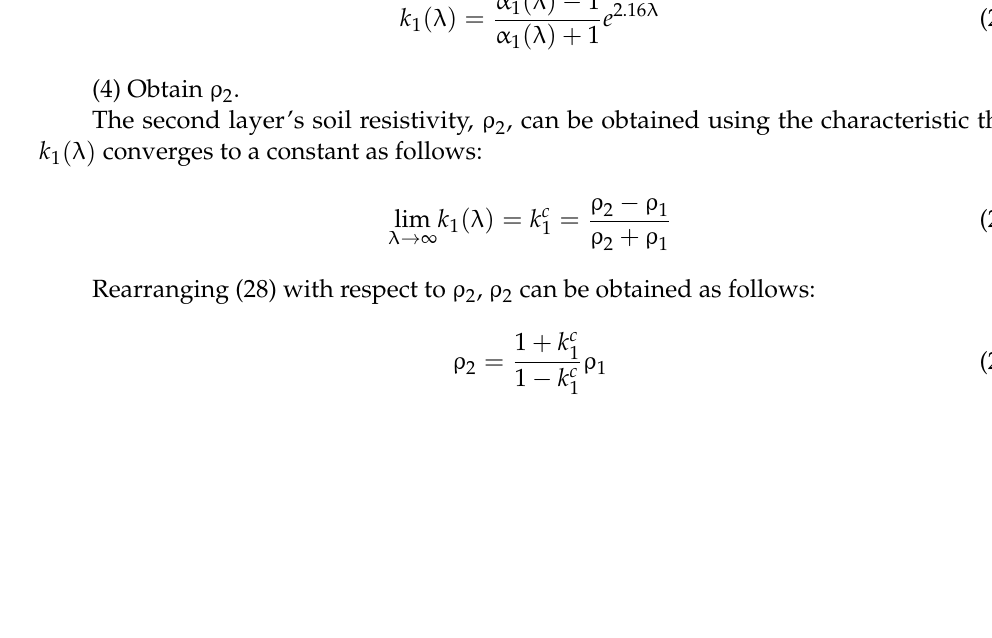
Figure 10.   (λ) according to the different ℎ  (4) Obtain ρ  The second layer’s soil resistivity, ρ  , can be obtained using the characteristic that   (λ) converges to a constant as follows: lim λ→∞  1 (λ) =  1 = ρ 2 − ρ 1 ρ 2 + ρ 1 (28) Rearranging (28) with respect to ρ  , ρ  can be obtained as follows: